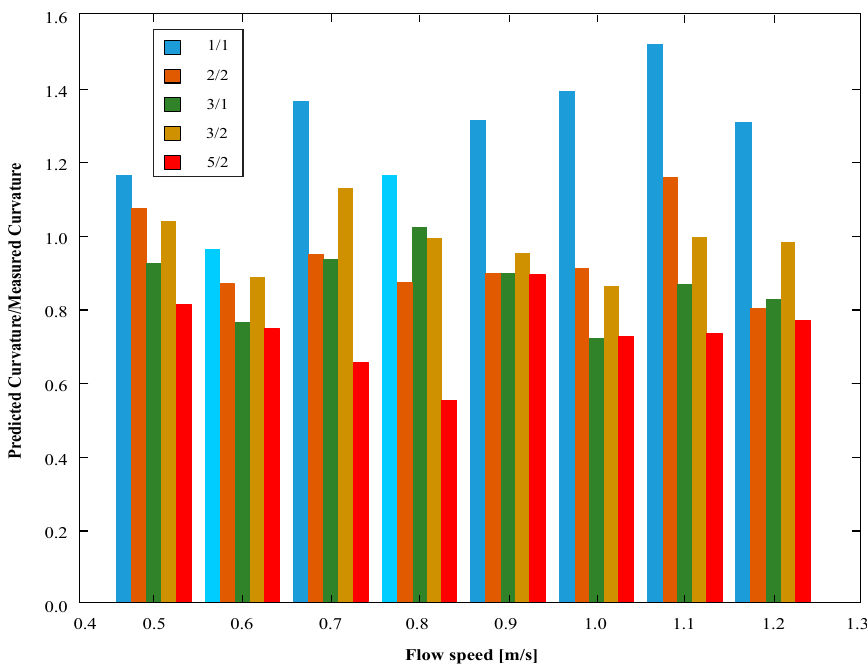
Figure 16. The ratio of the predicted over measured maximum RMS curvature values at different flow speeds for five configurations.